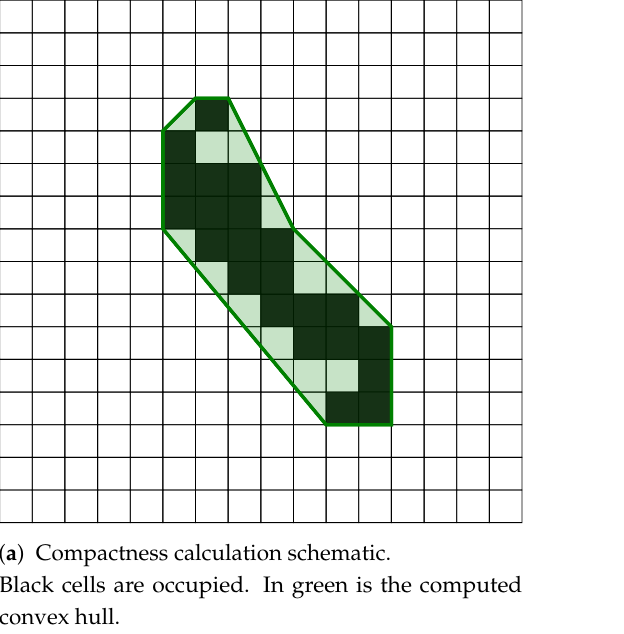
Figure 5. Schematic visualisation of key performance indicators